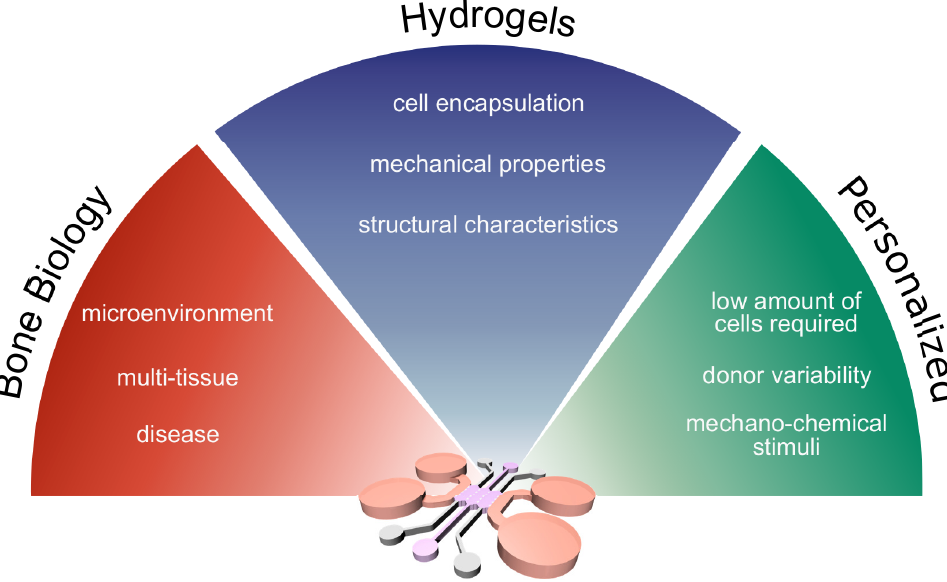
Figure 5. Modeling bone biology with personalized hydrogel-based bone-on-chips. Bone-on-chips aim at replicating specific functions of the bone tissue in sophisticated in vitro microenvironments. From a biological perspective, the variability associated with cell phenotype and bone diseases makes it difficult for traditional models to predict the efficacy of potential therapies. Each physiological or pathological bone process has a specific extracellular environment, which can be replicated by using hydrogels and tuning their biochemical composition, structural and mechanical properties. Therefore, hydrogel-based bone-on-chips offer personalized bone tissue models, where a proper combination of complex 3D microenvironments and primary human cells can answer questions on bone biology and test novel